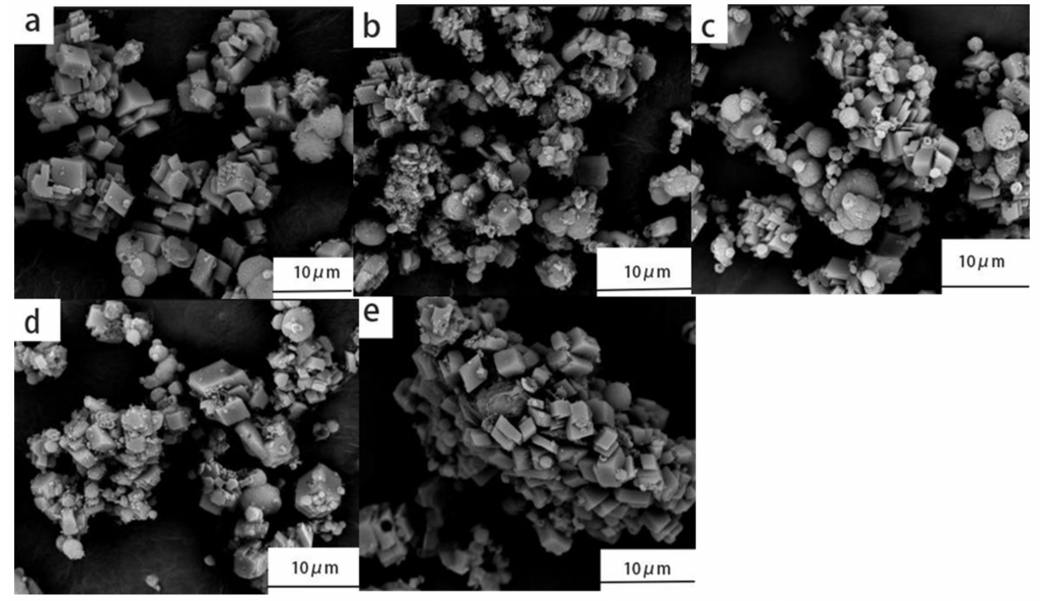
Figure 7. The e ff ects of magnesium carbonate dosage on the morphology of magnetized anti-scaling products: ( a ) 1%; ( b ) 2%; ( c ) 3%; ( d ) 4%; ( e )